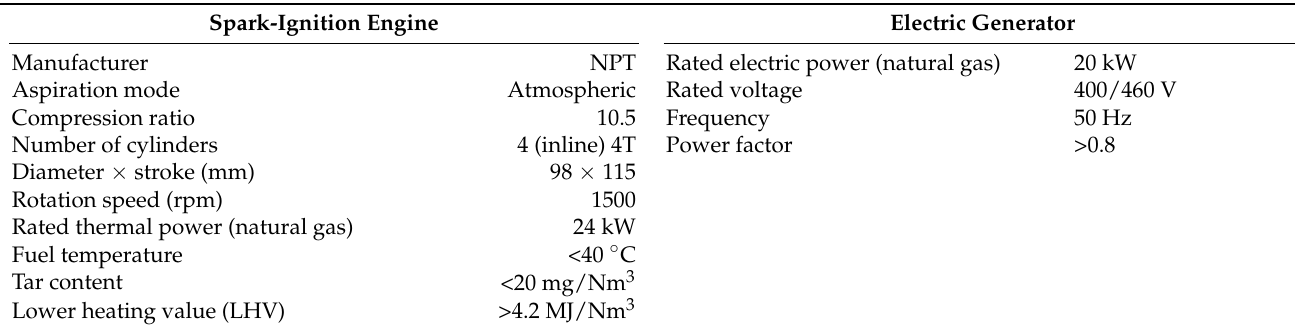
Table 4. Technical specifications of the engine–generator set.